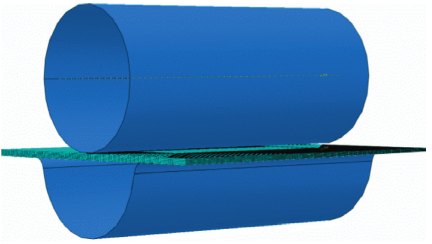
Figure 8: FEM of cylindrical bending of TRB.